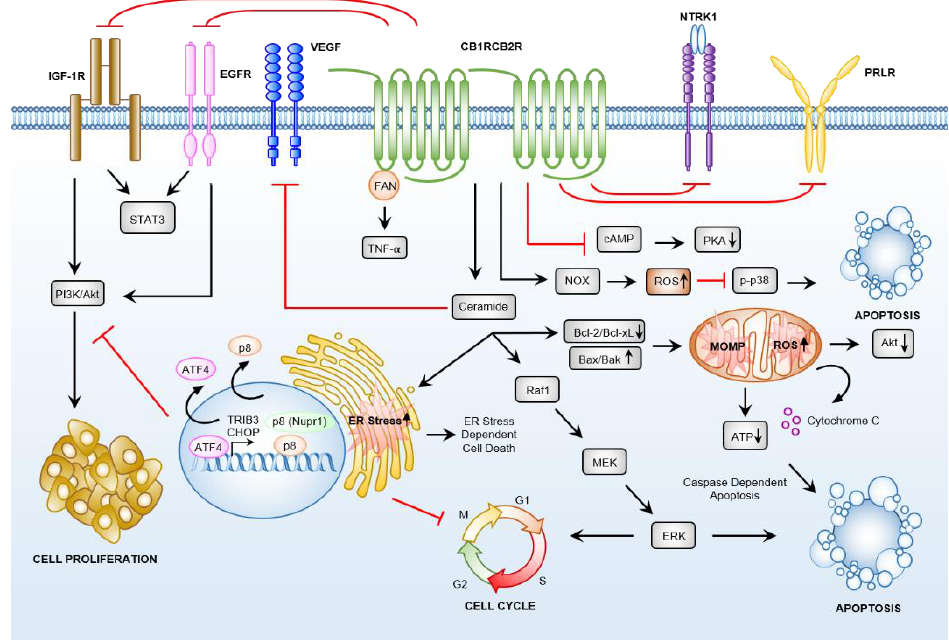
Figure 2. Cannabinoid induced anti-cancer crosstalk between G-protein-coupled receptor (GPCR) and non-GPCR signalling pathways is significant and complex. Cannabinoids interact with CB1R and CB2R and with non-cannabinoid receptors (CBRs) GPCRs (discussed in Section 3.3) to induce cancer cell death via promotion of cellular stress response pathways, increased ceramide synthesis, and reduced oncogenic growth and proliferation signalling.